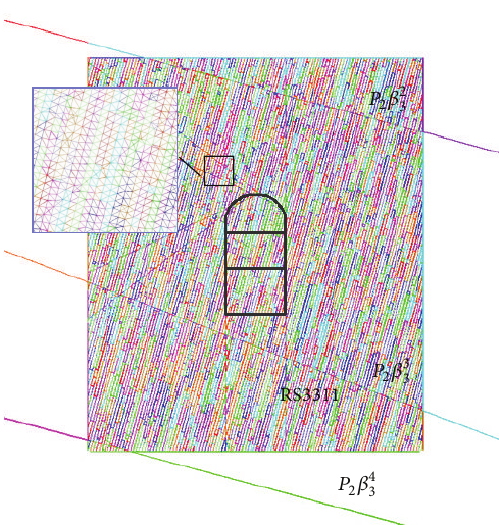
Figure 5: Calculated model of computation.